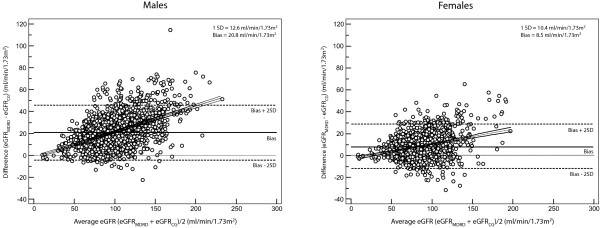
Bland-Altman plot of the eGFR measurements by CG and MDRD equations. Differences between eGFR measurements by CG/BSA and MDRD equation were plotted against the mean of two. The solid horizontal line represents the mean difference or the estimated bias. The MDRD equation had a positive bias as compared to CG/BSA equation, suggesting that MDRD equation overestimated GFR in the study population. The limits of agreement between two equations were broad (Males: -4.27 to 45.95 ml/min/1.73 m2, Females: -11.88 to 28.82 ml/min/1.73 m2). The thin dotted line represents a linear fit of data point. There was an increase in variance of MDRD eGFR estimates across eGFR range. eGFR, estimated glomerular filtration rate; CG/BSA, Cockcroft-Gault equation corrected for body surface area; MDRD, modification of diet in renal disease equation.